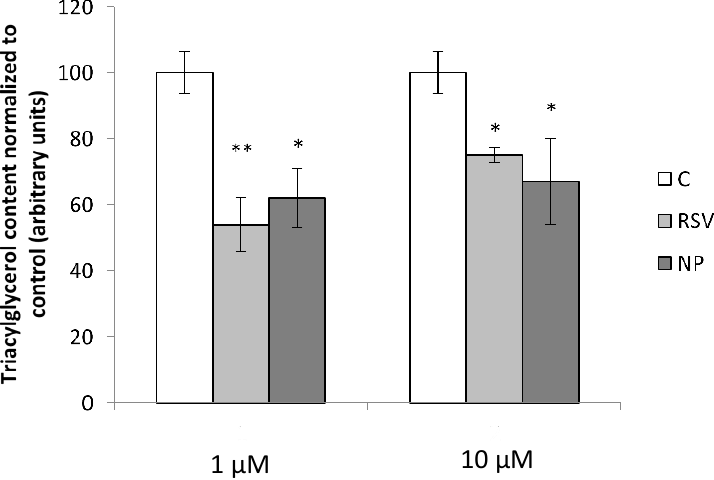
Figure 4. Triacylglycerol content in 3T3-L1 mature adipocytes after treatment with 1 and 10 µM free resveratrol (RSV) and RSV released from microparticles (NP). Values are means ± SEM. Comparison between each treatment with the control was analyzed by Student’s t -test. The asterisks represent differences versus the control (* p < 0.05; ** p < 0.01).